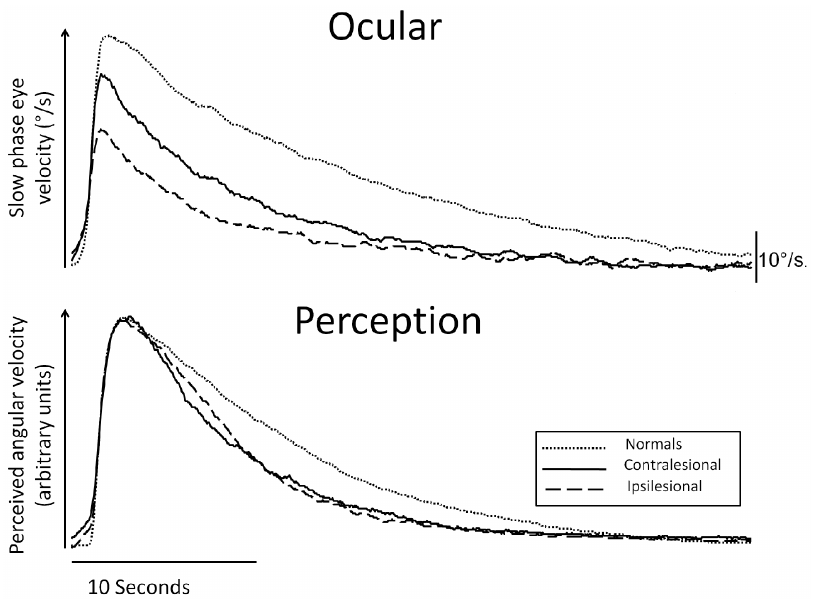
Figure 4. Grand average acute VO and VP responses during supra-threshold task. Grand averages of slow phase eye velocity (vestibulo- ocular) and perceived angular velocity (perception, normalised) in response to 90 u /s velocity steps, for normal controls (dotted line) and acute VN patients when accelerating towards the side of the lesion (ipsilesional, dashed line) and towards the healthy side (contralesional, solid line). Note symmetrical and shorter time constants for perceptual data despite grossly asymmetrical ocular responses in acute VN patients.